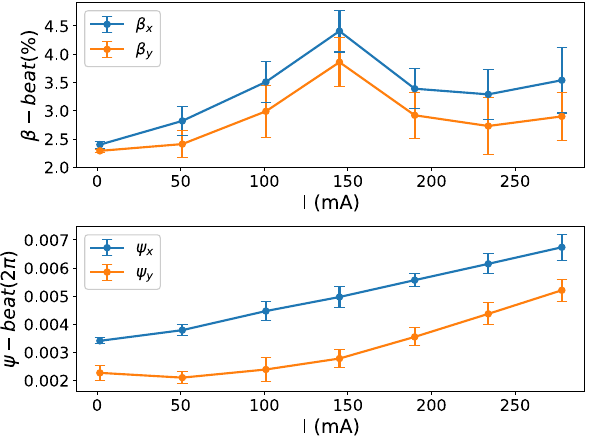
FIG. 9. β -beat (top) and phase beat (bottom) in relation to stored beam currents.